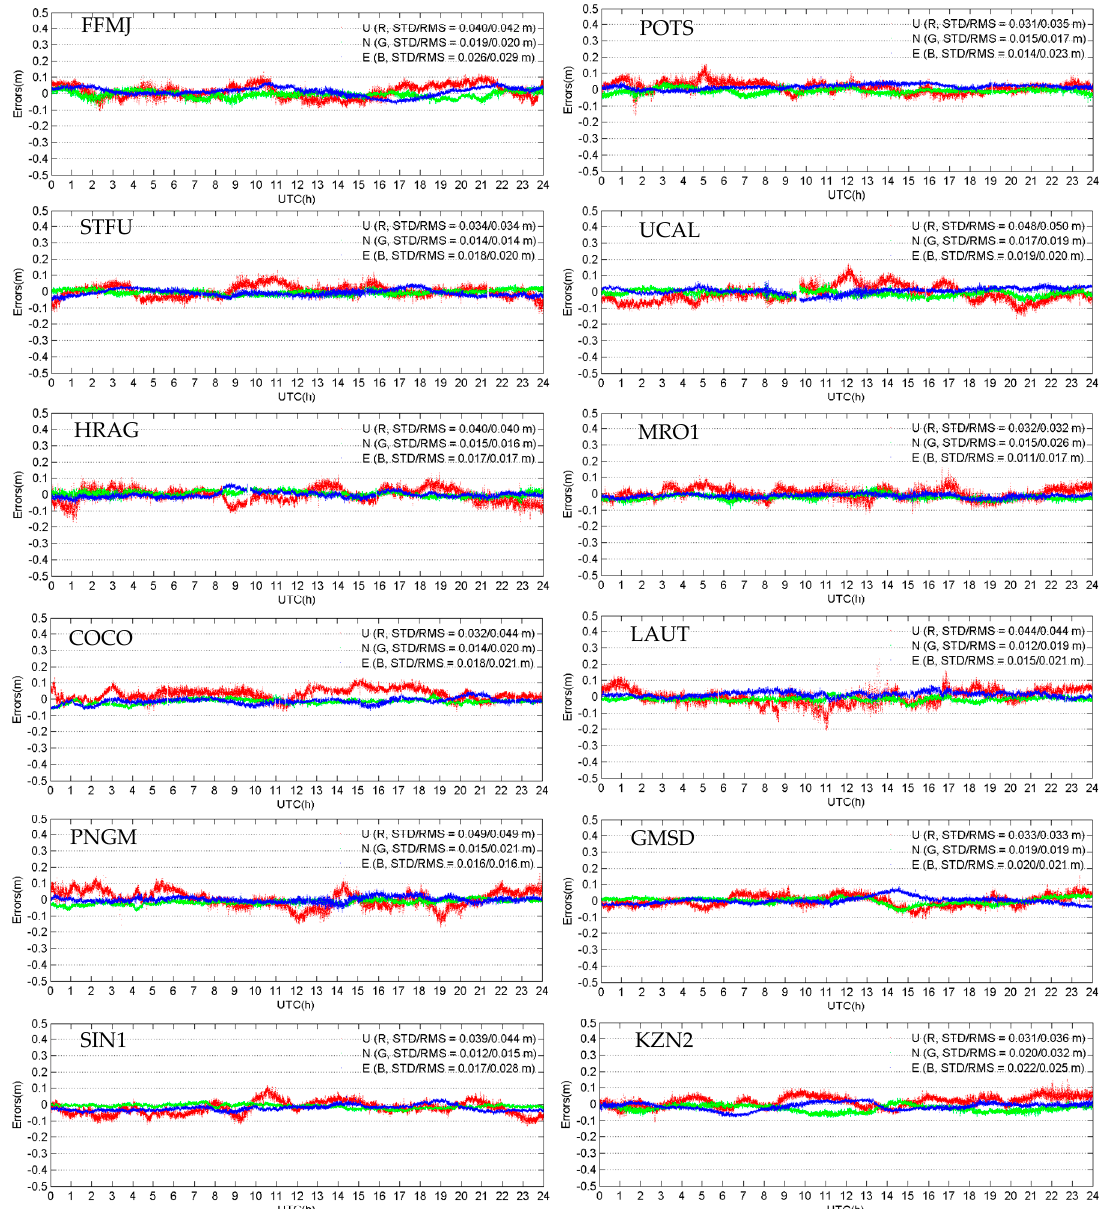
Figure 8. An example of the time series of positioning errors on the second day for each station.